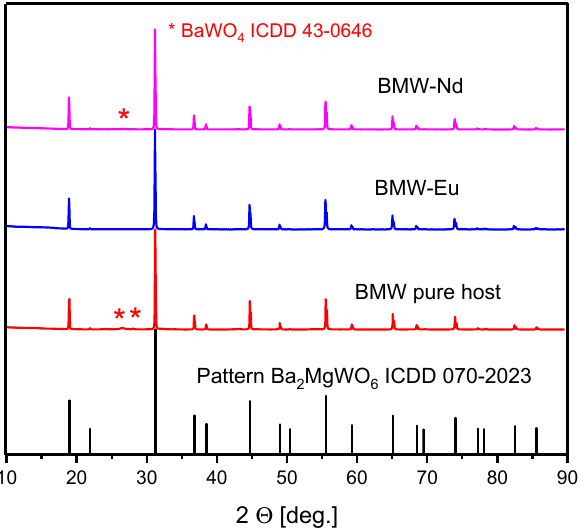
Figure 2. XRD patterns of the polycrystalline powders: BMW, BMW-Eu, and BMW-Nd. The SEM images of the BMW, BMW-Eu, and BMW-Nd powders are presented in Figure 3. The grains tend to agglomerate, but individual grains also appear. The grains are of relatively large sizes in the range of 490 nm – 2 µm; however, the BMW-Nd compo- sition has the smallest size (Table 1). The analysis of SEM images shows that the solid- state synthesis produces isotropic, slightly agglomerated, and submicrometric double per- ovskite powders, such as Ba 2 MgWO 6 ; therefore, these materials should exhibit good sin- terability. (a) (b) (c) Figure 3. SEM images of the polycrystalline powders: BMW ( a ), BMW-Eu ( b ), and BMW-Nd ( c ). In our previous work [6], an analysis of the thermal behavior with the natural sinter- ing method was performed using dilatometry and the TG-DSC analysis in air, which sup- plements the test results obtained. The measurements were caried out on the BMW host and were described in detail in the previous paper [6], and therefore were not included in this paper. Overall, the dilatometry results show that our BMW powders have excellent compaction ability, which may be related to the low friction and rearrangement forces experienced during compaction. In addition, the sinterability of BMW synthetic powders remains low during natural sintering, which can be explained by the large grain size. The obtained results of TG-DSC indicate that the sintering temperature of this material should